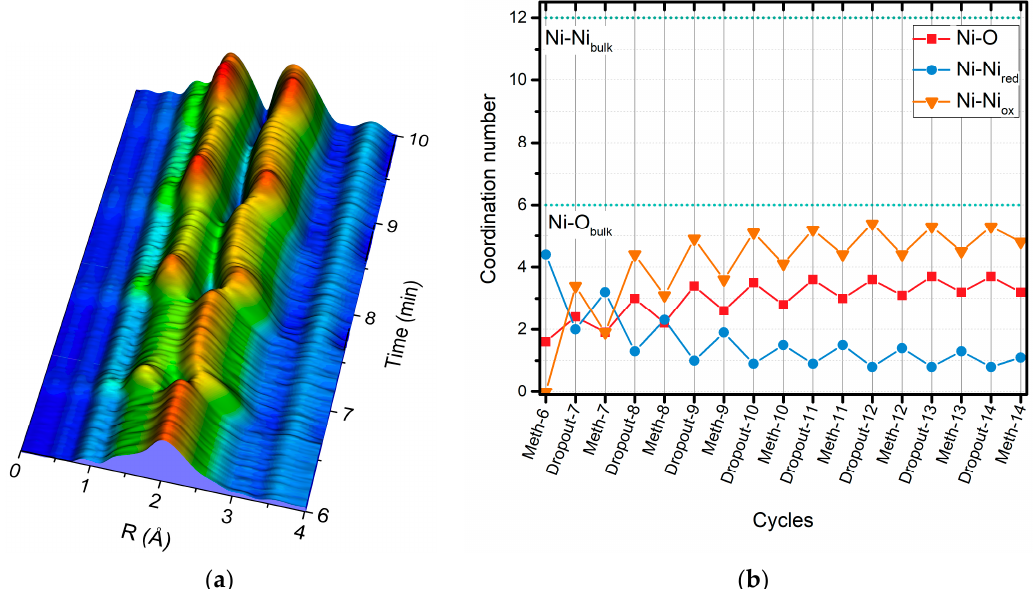
Figure 5. ( a ) Fourier-transformed extended X-ray absorption fine structure (FT EXAFS) data ( k : 3–11 Å − 1 ; k 2 -weighted, not phase corrected) during 30-s H 2 dropouts (starting at the methanation sequence before the seventh H 2 dropout (Meth-6)); ( b ) Results of the EXAFS fitting analysis during the 30-s modulation. The final spectra of each sequence (methanation sequences labeled as “Meth”) were analyzed (details, cf. the Supplementary Materials). The coordination numbers (N) of neighboring atoms are presented: Ni-O and Ni-Ni ox correspond to O and Ni coordination numbers, respectively, in oxidized nickel and Ni-Ni red to the coordination number of the first nickel shell in reduced nickel.